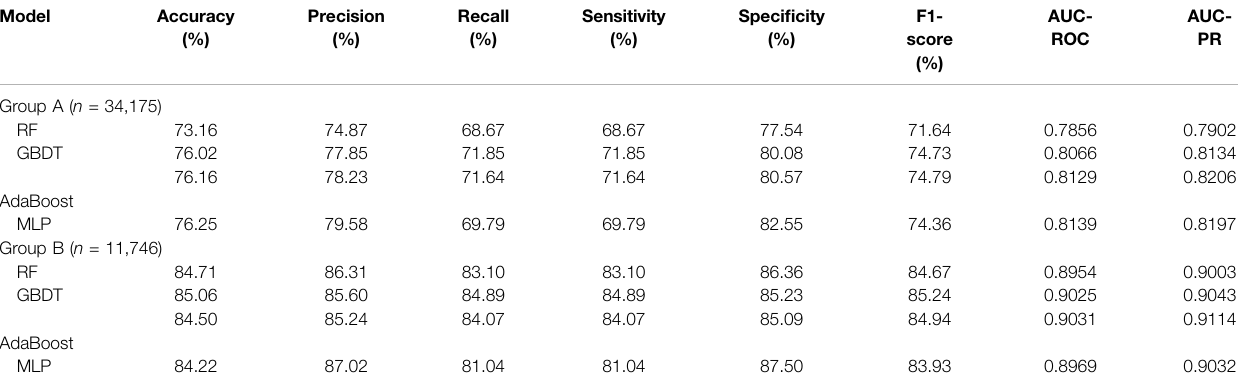
TABLE 2 | Evaluation metrics of all